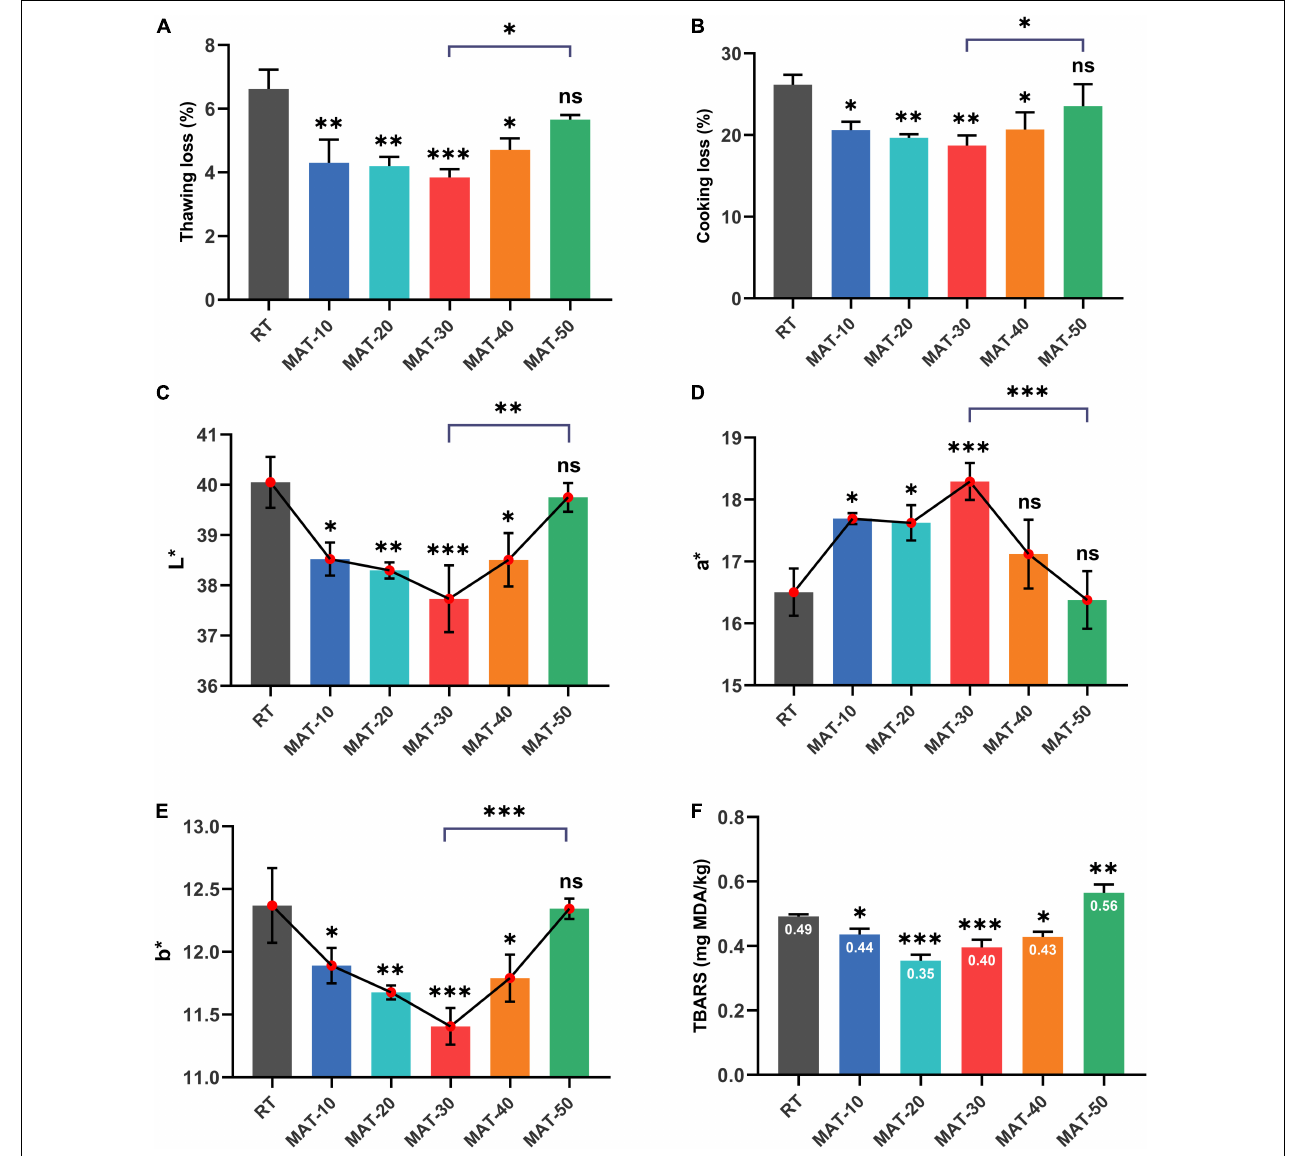
FIGURE 4 | The quality parameters of frozen beef with different thawing treatments. (A) Thawing loss. (B) Cooking loss. (C) L* values. (D) a* values. (E) b* values. (F) TBARS values. ∗ indicates P < 0.05, ∗∗ indicates P < 0.01, ∗∗∗ indicates P <